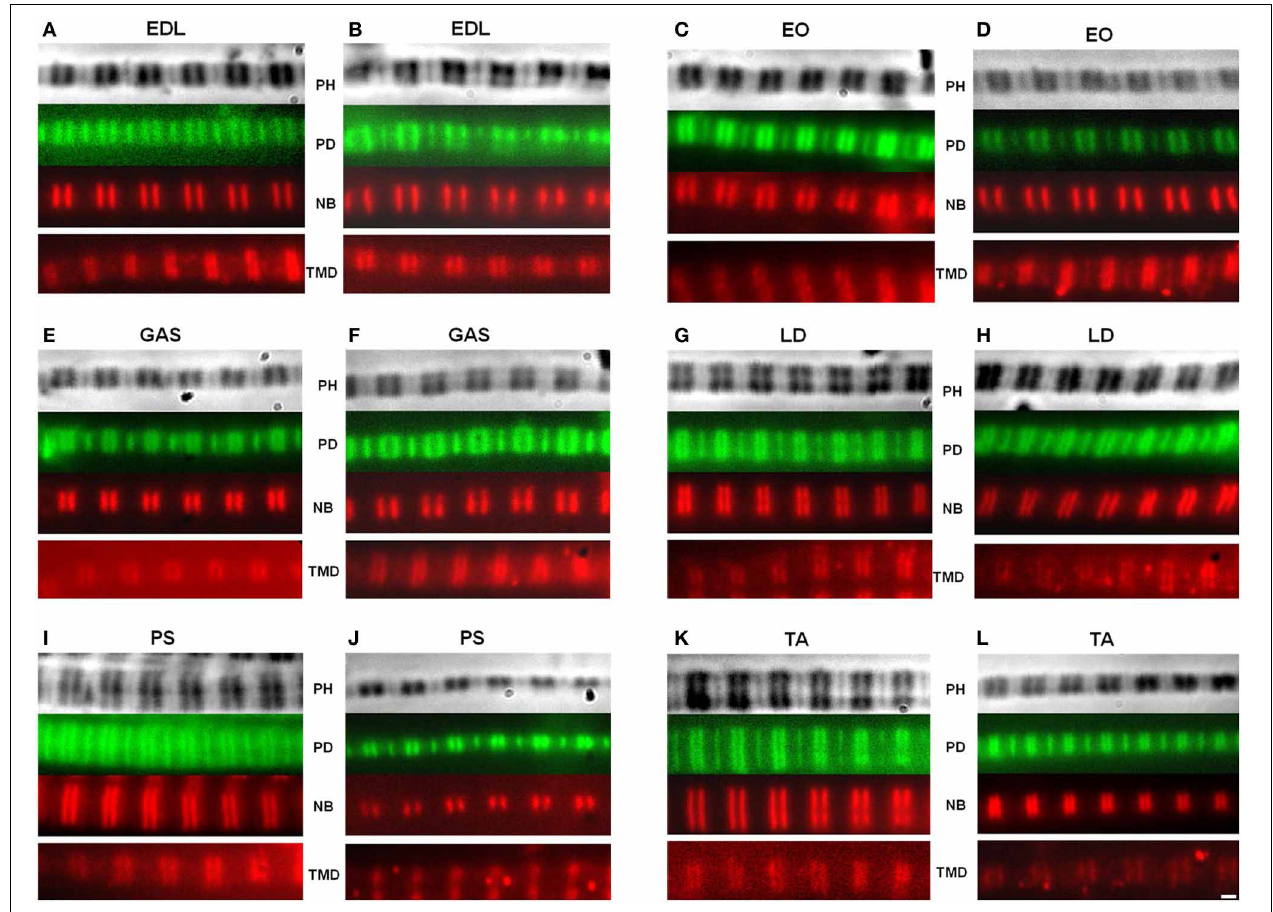
FIGURE 2 | Representative images of myofibrils. The actin filaments were observed using fluorescein isothiocyanate (FITC), while the nebulin and tropomodulin doublets were measured using a Texas Red secondary antibody. A matched set of phase contrast, actin, and nebulin images were obtained. The tropomodulin image was from a separate myofibril with a similar sarcomere length. Top: phase contrast